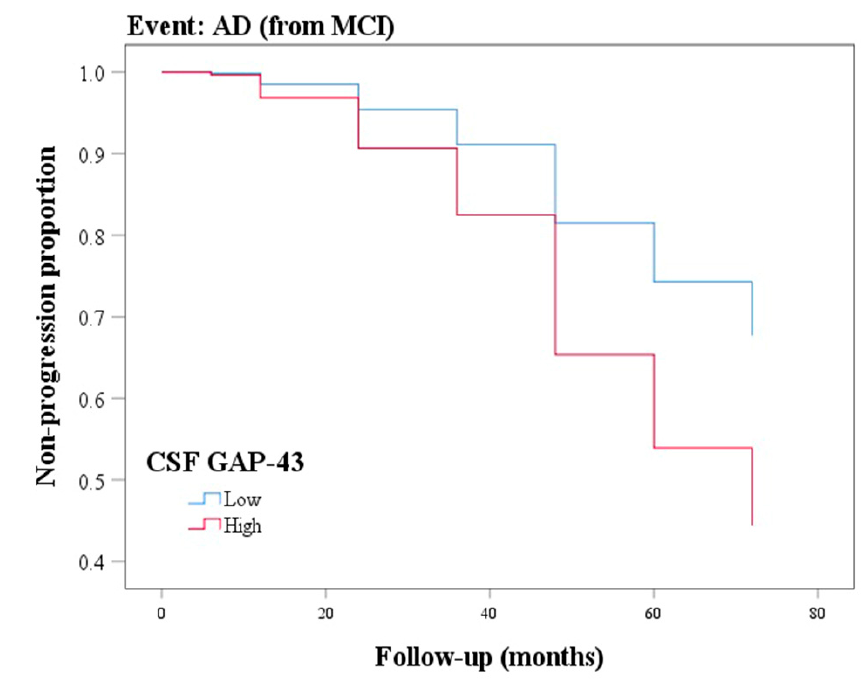
Figure 4. Baseline CSF GAP-43 as a predictor of conversion from MCI to AD. GAP-43 was analyzed as categorical variables using median value in the Cox proportional hazard model, after adjustment for age, sex, and education. GAP-43: growth-associated protein 43; MCI: mild cognitive impairment; AD: Alzheimer’s disease.